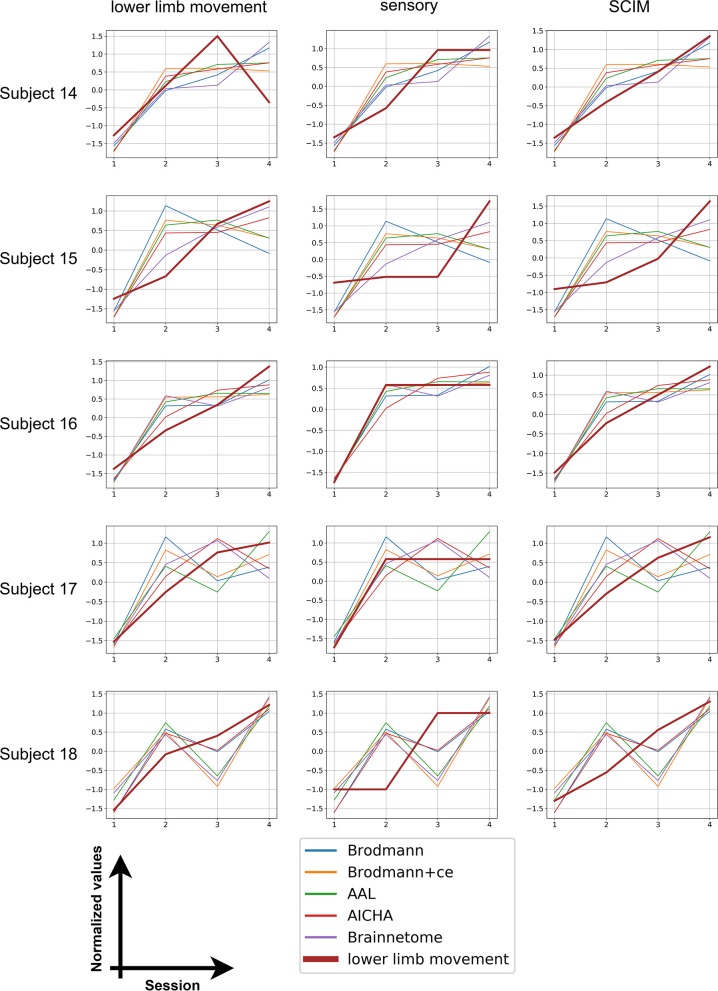
Longitudinal results. The bold brown line stands for clinical scores whereas thinner lines with five different colors represent the distance calculated from five different atlases.